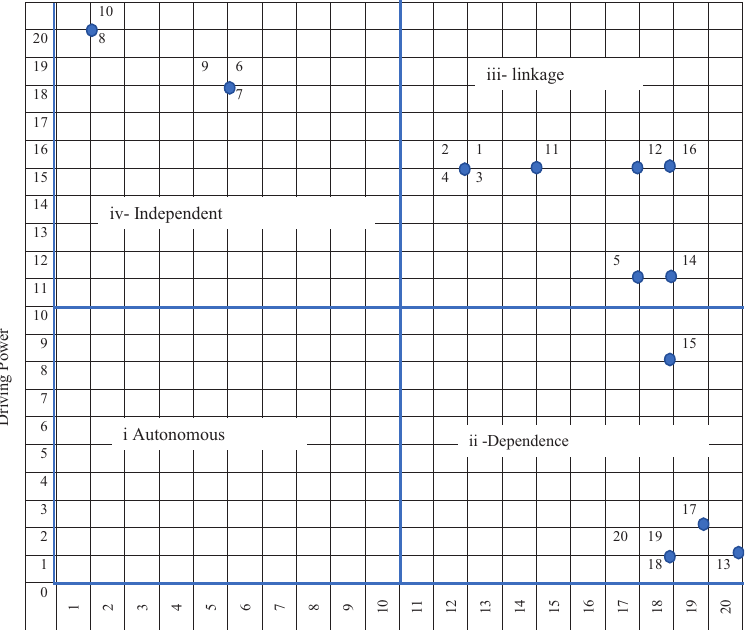
Figure 3. MICMAC